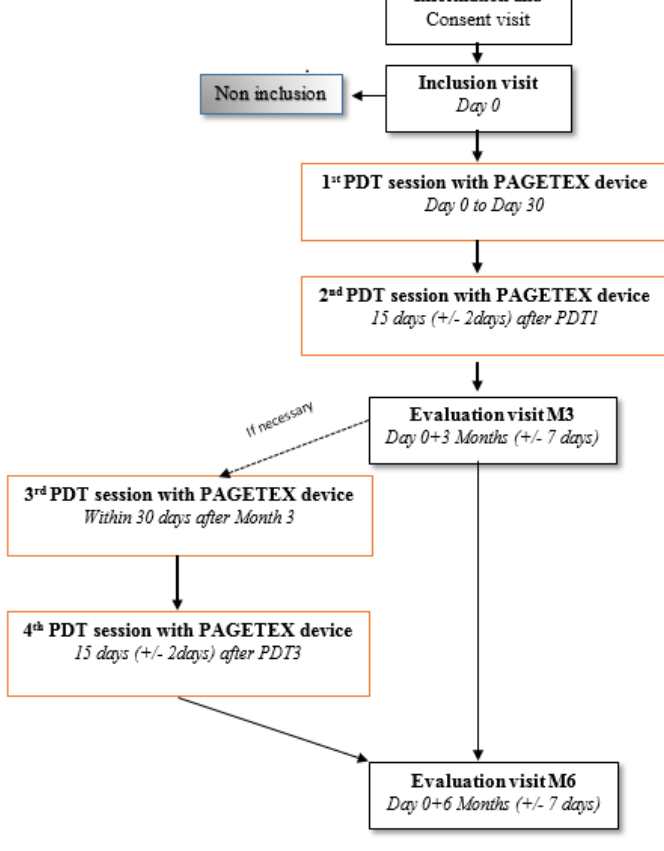
Figure 4. Progress of study visits. M: month; PDT: photodynamic